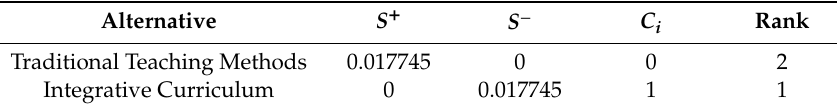
Table A4. The Eulidean distance, the relative closeness coe ffi cient, and